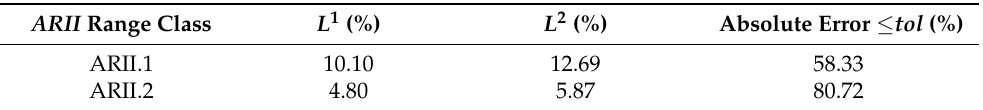
Figure 6. Example 3.0.2 Predicted temperature versus monitored and outdoor temperatures inside an ARI.2 courtyard. Table 10. Example 3.0.2. Relative and absolute errors for the courtyard measured temperature in each selected courtyard of each ARII range class.